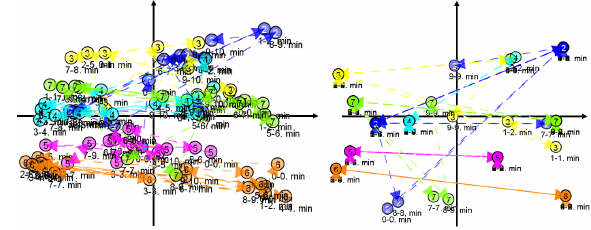
Figure 13. The detected changes using two different parameter settings. The changes are given in the group movement frame (black arrows). Left: many changes are found by using windowSize = 20 s and (cid:15) = 3 m . Right: less but more significant changes remain using windowSize = 40 s and (cid:15) = 10 m .